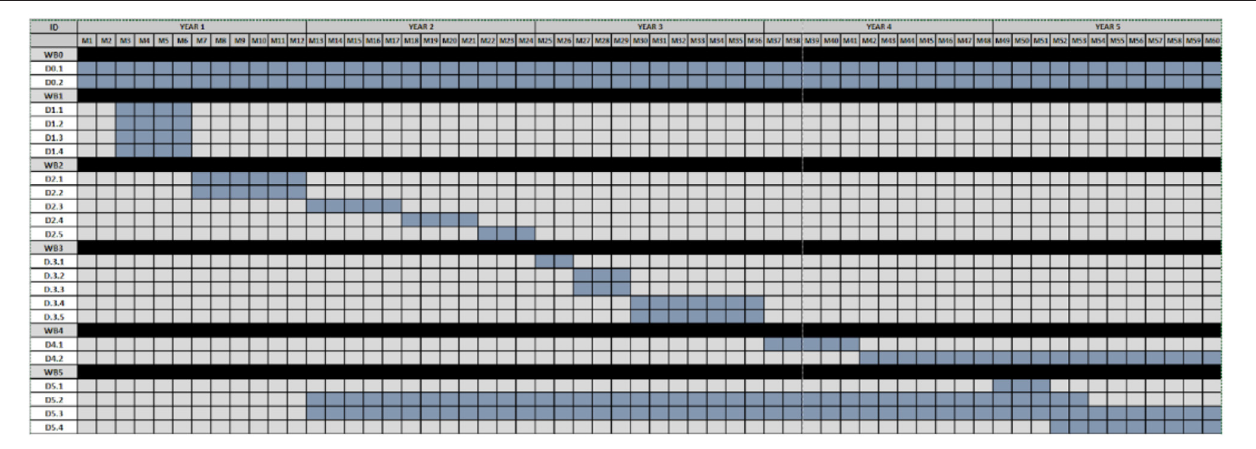
FIGURE 6 | Gantt chart of project